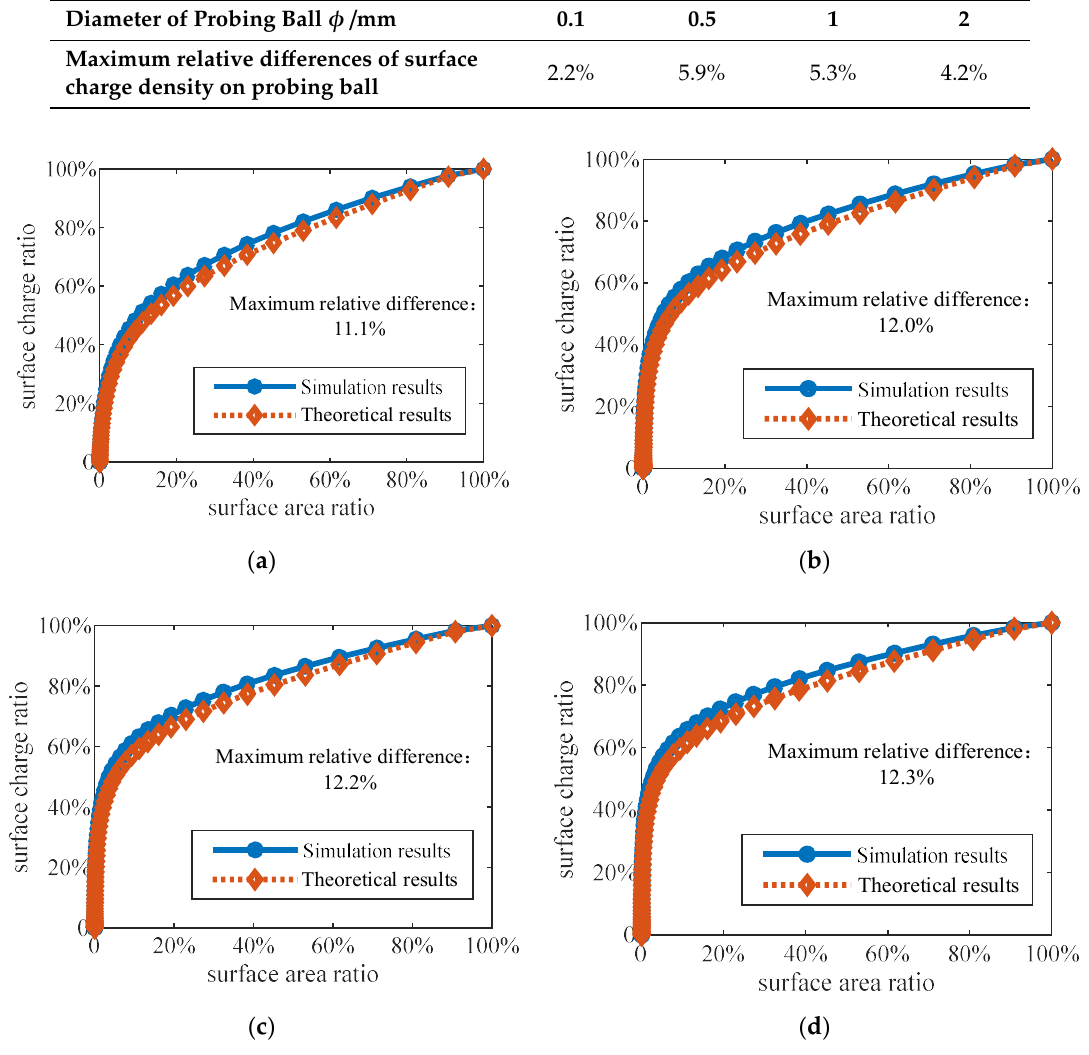
Figure 7. Surface charge ratio as a function of the surface area ratio for probing balls with different diameters. ( a ) ϕ 0.1 mm; ( b ) ϕ 0.5 mm; ( c ) ϕ 1 mm; ( d ) ϕ 2 mm.